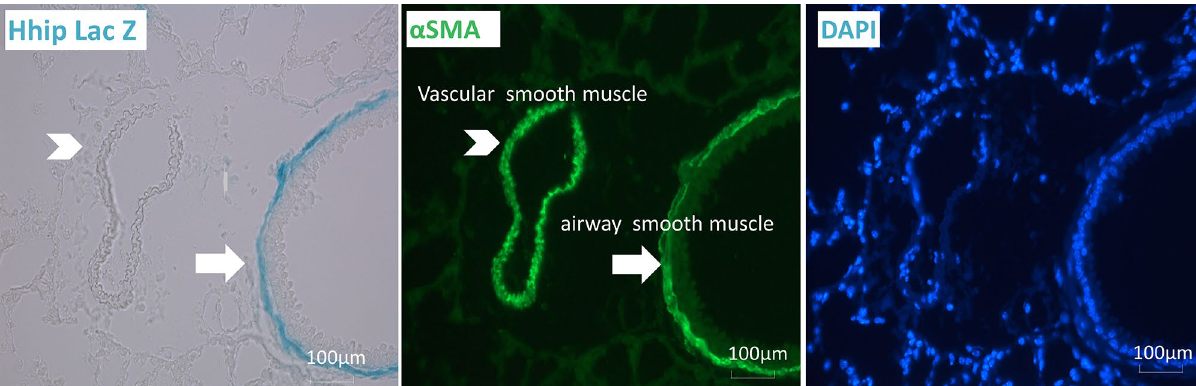
Figure 4. Hhip is expressed in ASMCs (airway lung) as indicated by LacZ staining in Hhip + /- mice. A representative image of histology of lung sections from unchallenged Hhip + /- mice at 2 months of age. LacZ staining (left panel), α-smooth muscle actin staining (middle panel), and DAPI staining (right panel) are demonstrated. Scale bars, 100 μm. Arrows indicate the localization of Hhip in the lungs. Arrowheads indicate vascular smooth muscle